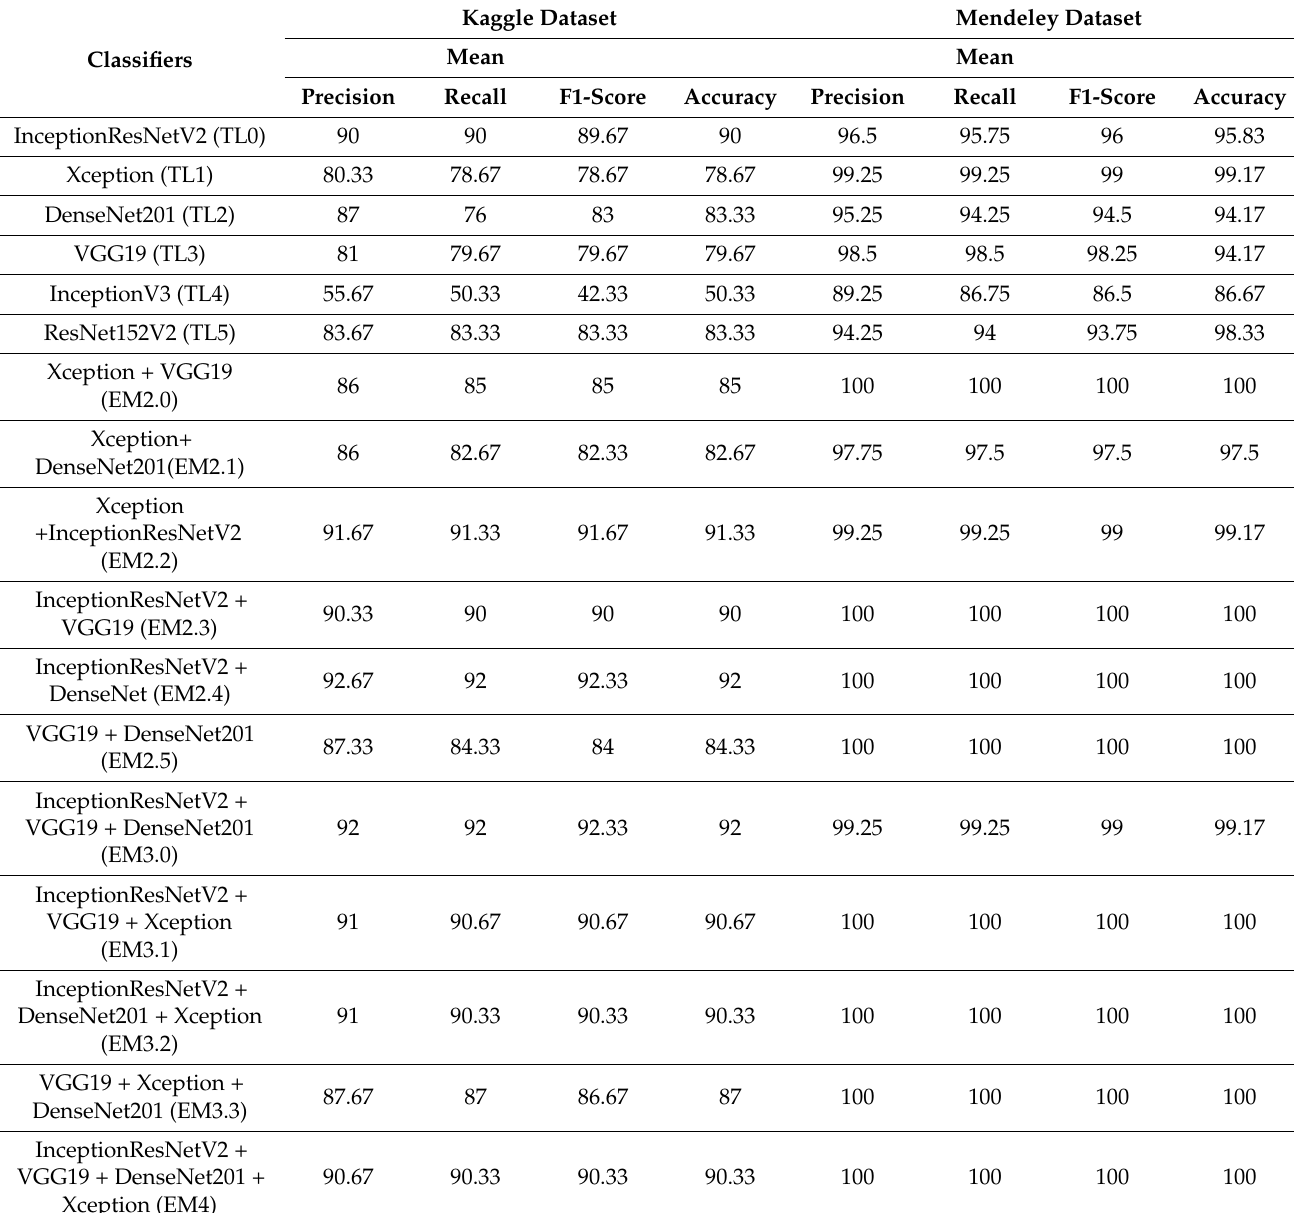
Table 5. Performance metrics for transfer learning models and the proposed ensemble models used in this